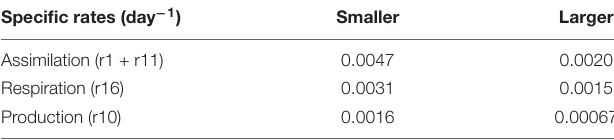
TABLE 4 | Model-based specific rates (day − 1 ) for small and larger Geodia